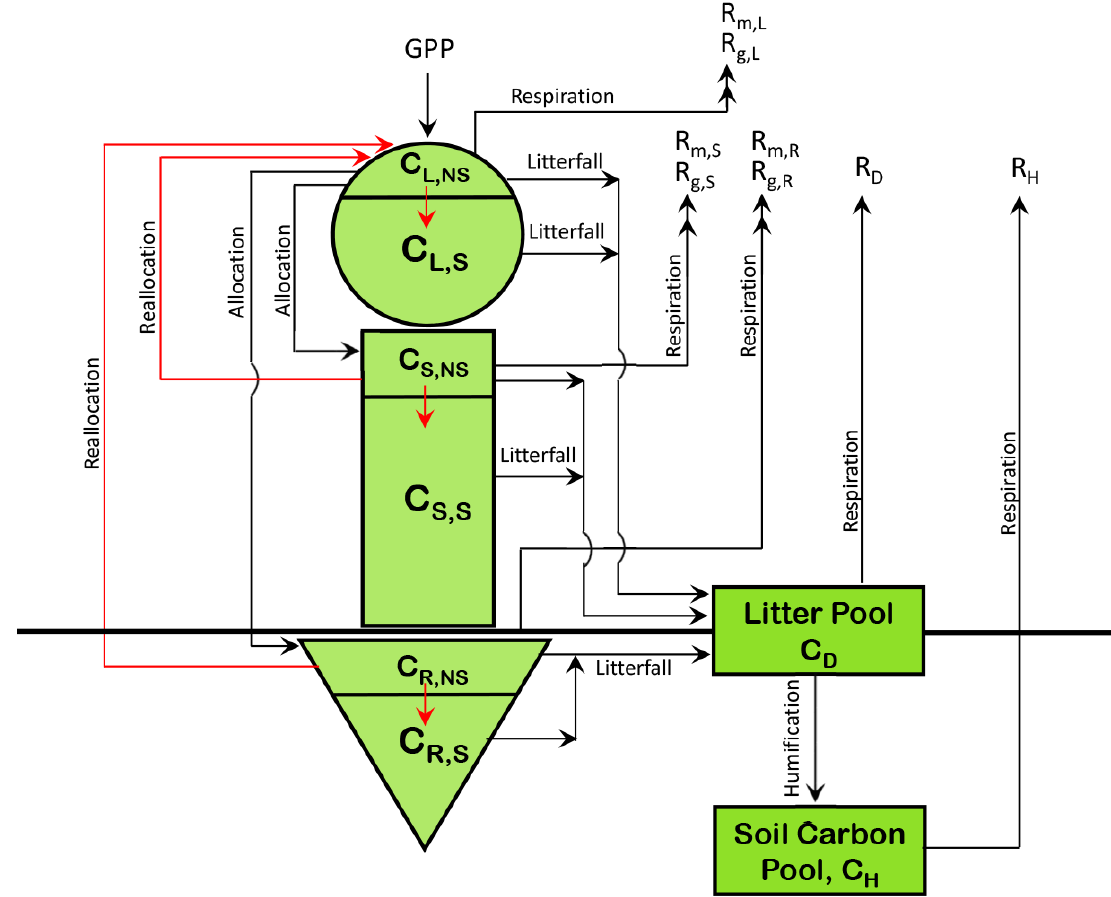
Figure A1. The structure of the CLASSIC model used in this study, upon which the N cycle is implemented, with its carbon pools and fluxes. The fluxes of non-structural carbon are shown in a red colour.